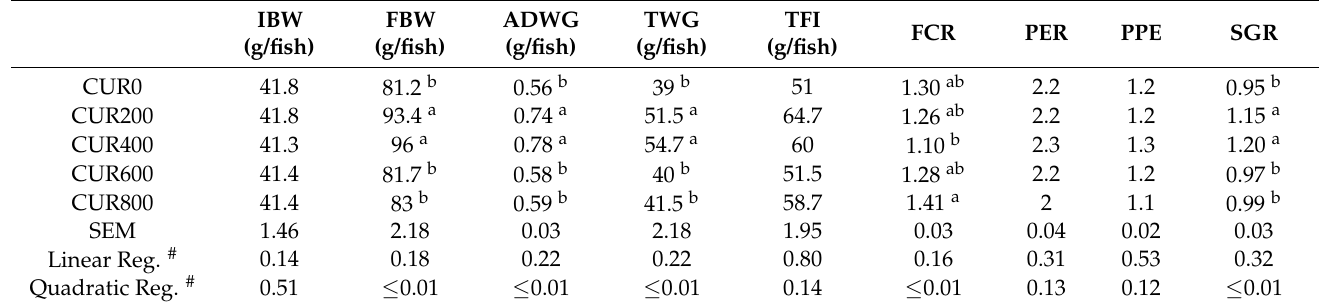
Table 2. Effect of dietary curcumin (CUR) on the growth performance of O. niloticus .